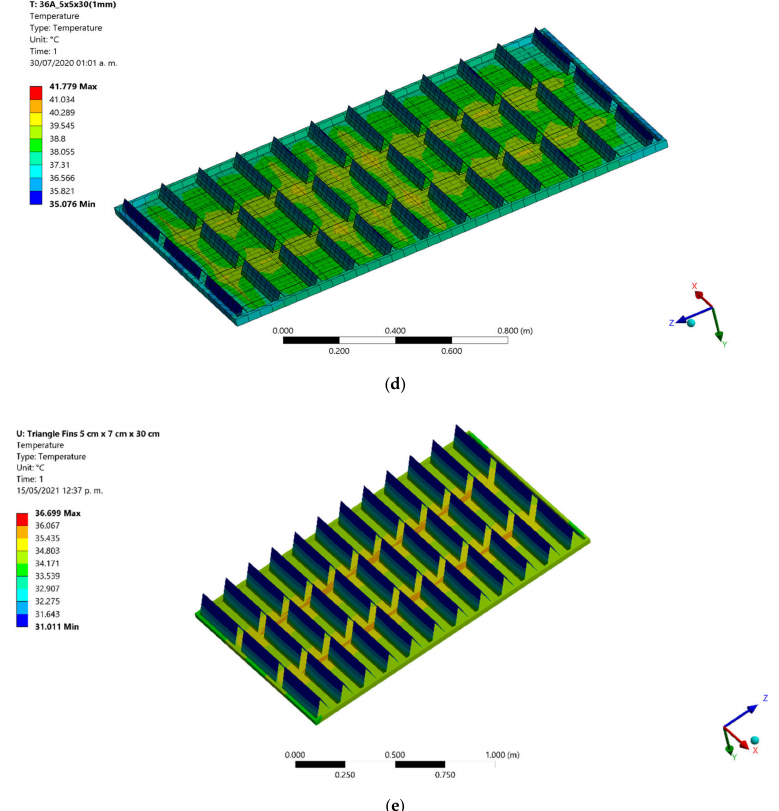
Figure 7. Temperature fields. ( a ) Temperature distribution of the whole panel EVA 0.5 mm. ( b ) Temperature distribution of the whole panel, EVA 0.2 mm. ( c ) Temperature distribution of the whole panel with rectangular fins. ( d ) Temperature distribution of the whole panel, EVA 0.2 mm. ( e ) Temperature distribution of the whole panel, fins 1 mm of thickness EVA 0.2